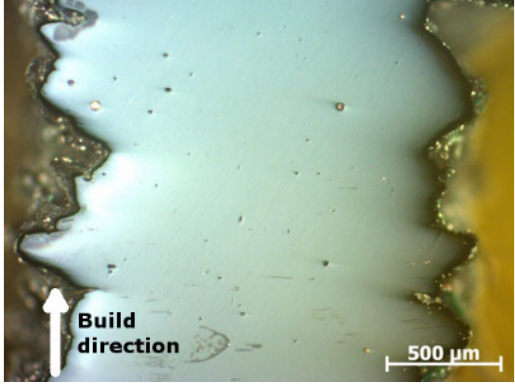
Figure 12. Vertical 1.5 mm strut built with the modified scan strategy.